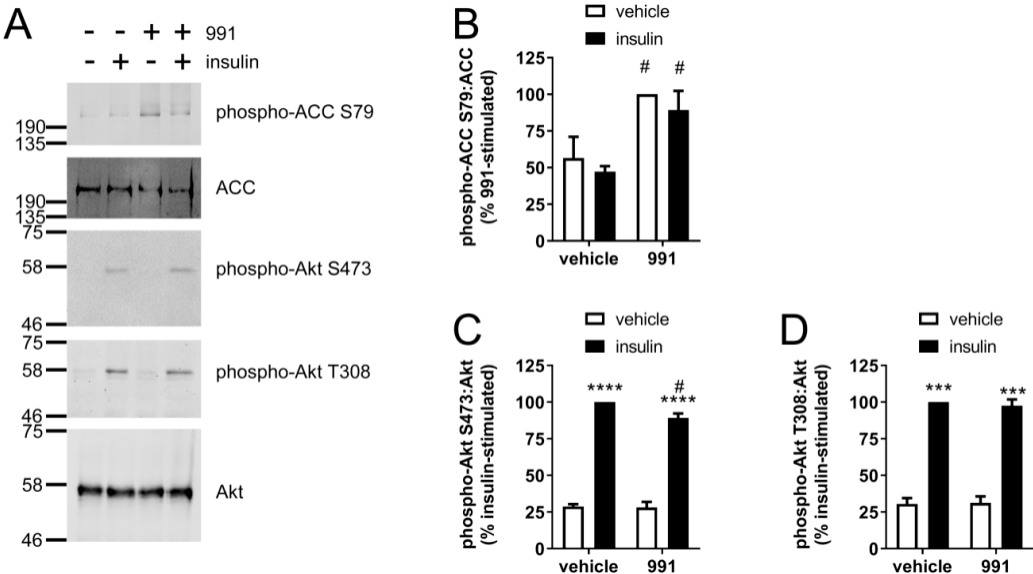
Figure 2. The effect of compound 991 on insulin-stimulated Akt phosphorylation in HUVECs. HUVECs were stimulated with compound 991 (5 µM, 45 min) prior to insulin (1 µM, 15 min) and cell lysates prepared. Proteins were resolved by SDS-PAGE and immunoblotted with the antibodies indicated. ( A ) Representative immunoblots from three biological replicates with molecular weight markers indicated. Phospho-Akt Thr308 protein levels were assessed by stripping and re-probing the membranes. Densitometric quantification of ( B ) ACC Ser79, ( C ) Akt Ser473 and ( D ) Akt Thr308 phosphorylation normalised to ACC or Akt (mean ± SEM). *** p < 0.001, **** p <0.0001 relative to absence of insulin. # p <0.05 relative to absence of compound 991 .